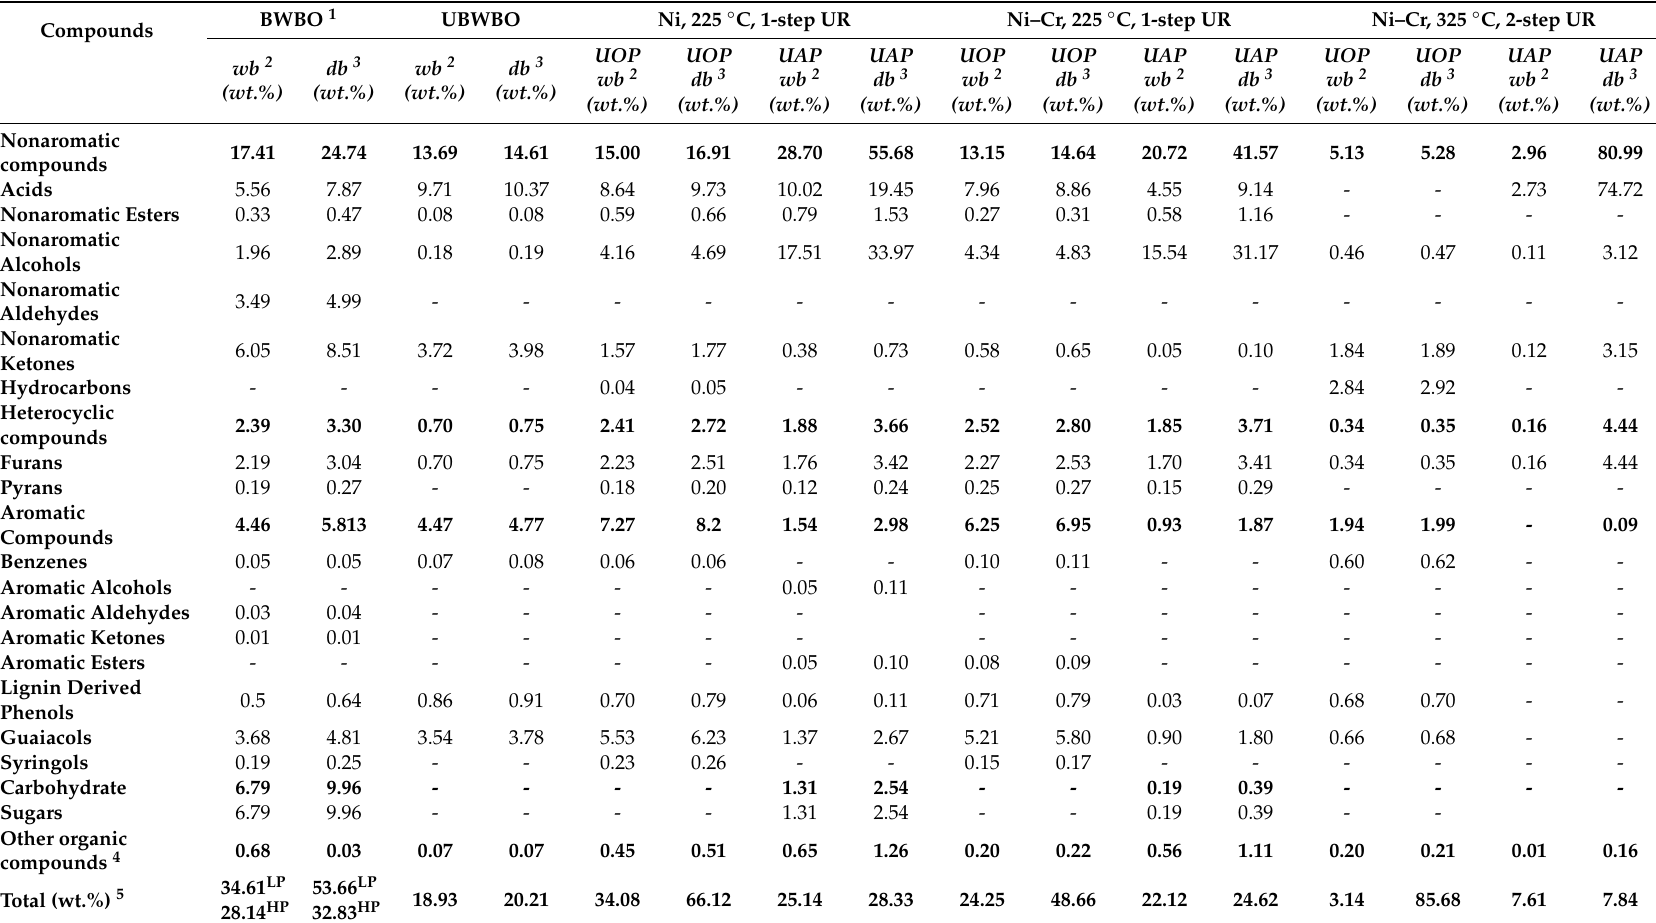
Table 3. Quantification of GC-MS / FID detectable compounds in the feedstock and upgraded liquid